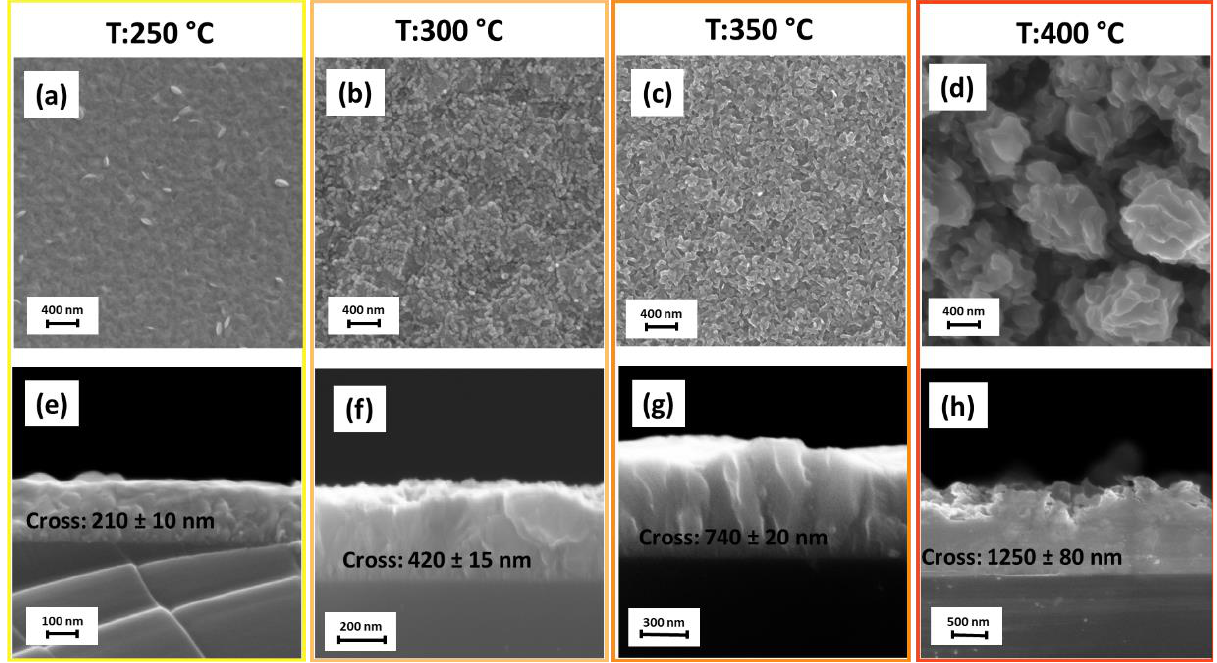
Figure 2. FE-SEM images of Cu 2 O and CuO thin films prepared by MOCVD on Si substrate deposited at 250 °C: ( a ) plan view and ( e ) cross-section; at 300 °C: ( b ) plan view and ( f ) cross-section; at 350 °C: ( c ) plan view and ( g ) cross-section; at 400 °C: ( d ) plan view and ( h ) cross-section.